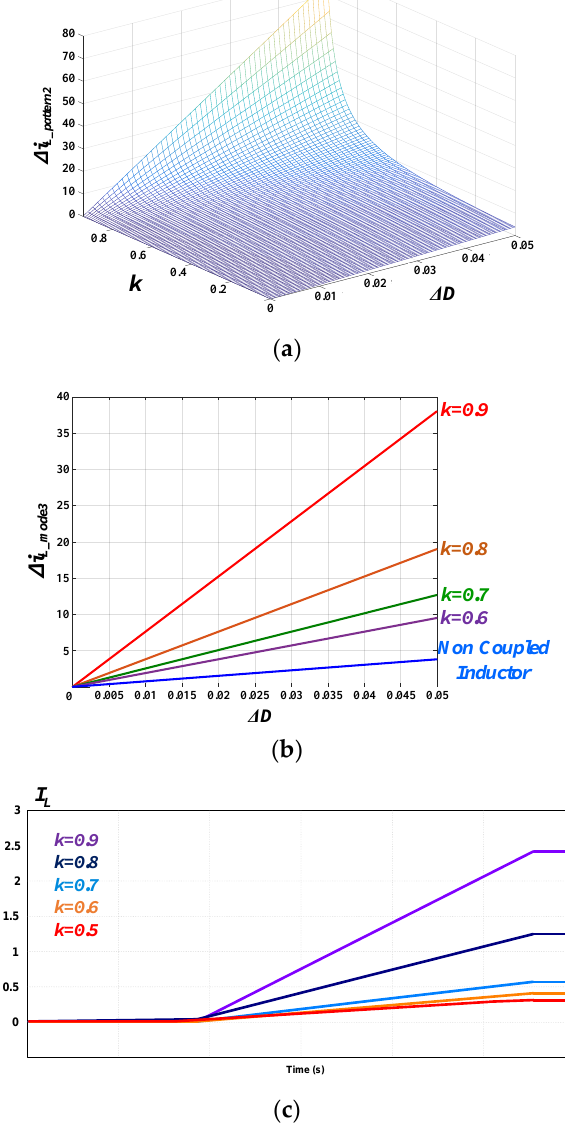
Figure 7. Inductor current variation by coupling coefficient: ( a ) Current variation curves with different coupling coefficients and duty ratios in switching pattern 2, ( b ) comparison of different coupling coefficients in operation mode 3, ( c ) current variation curves of total inductor current with different coupling coefficients.